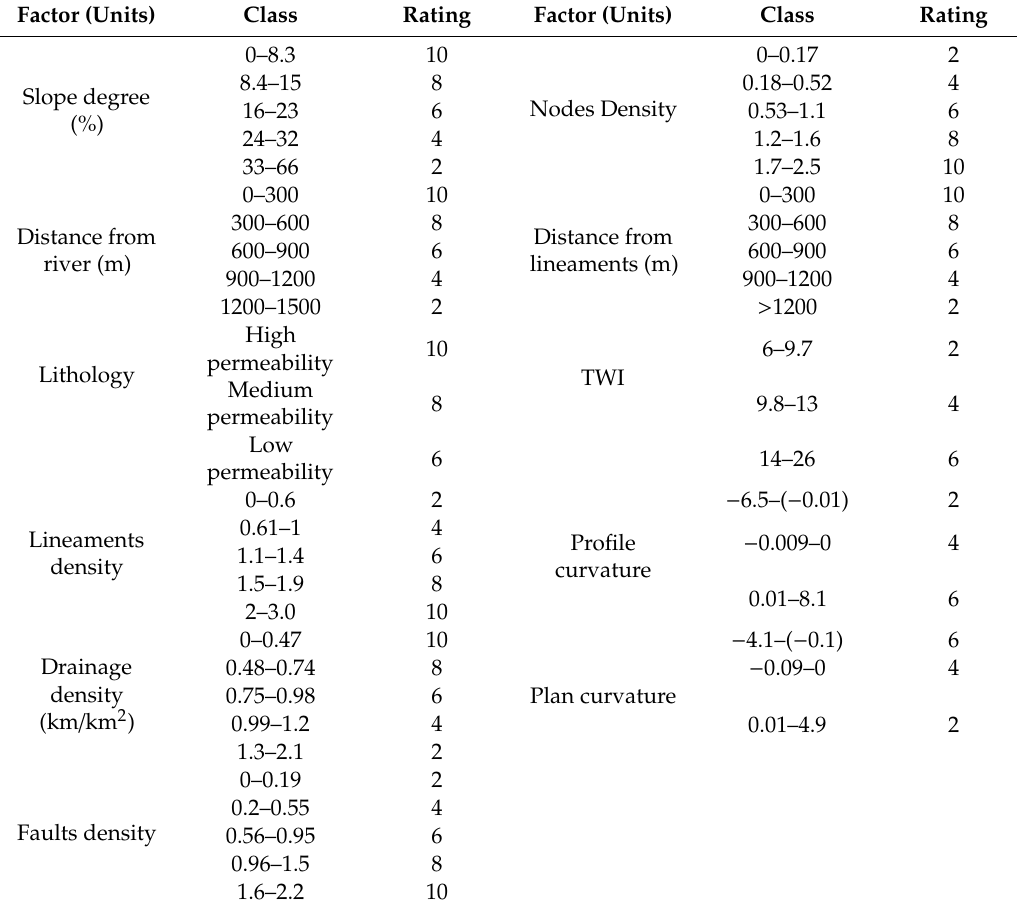
Table 1. Intervals of standardization of the evaluation criteria.